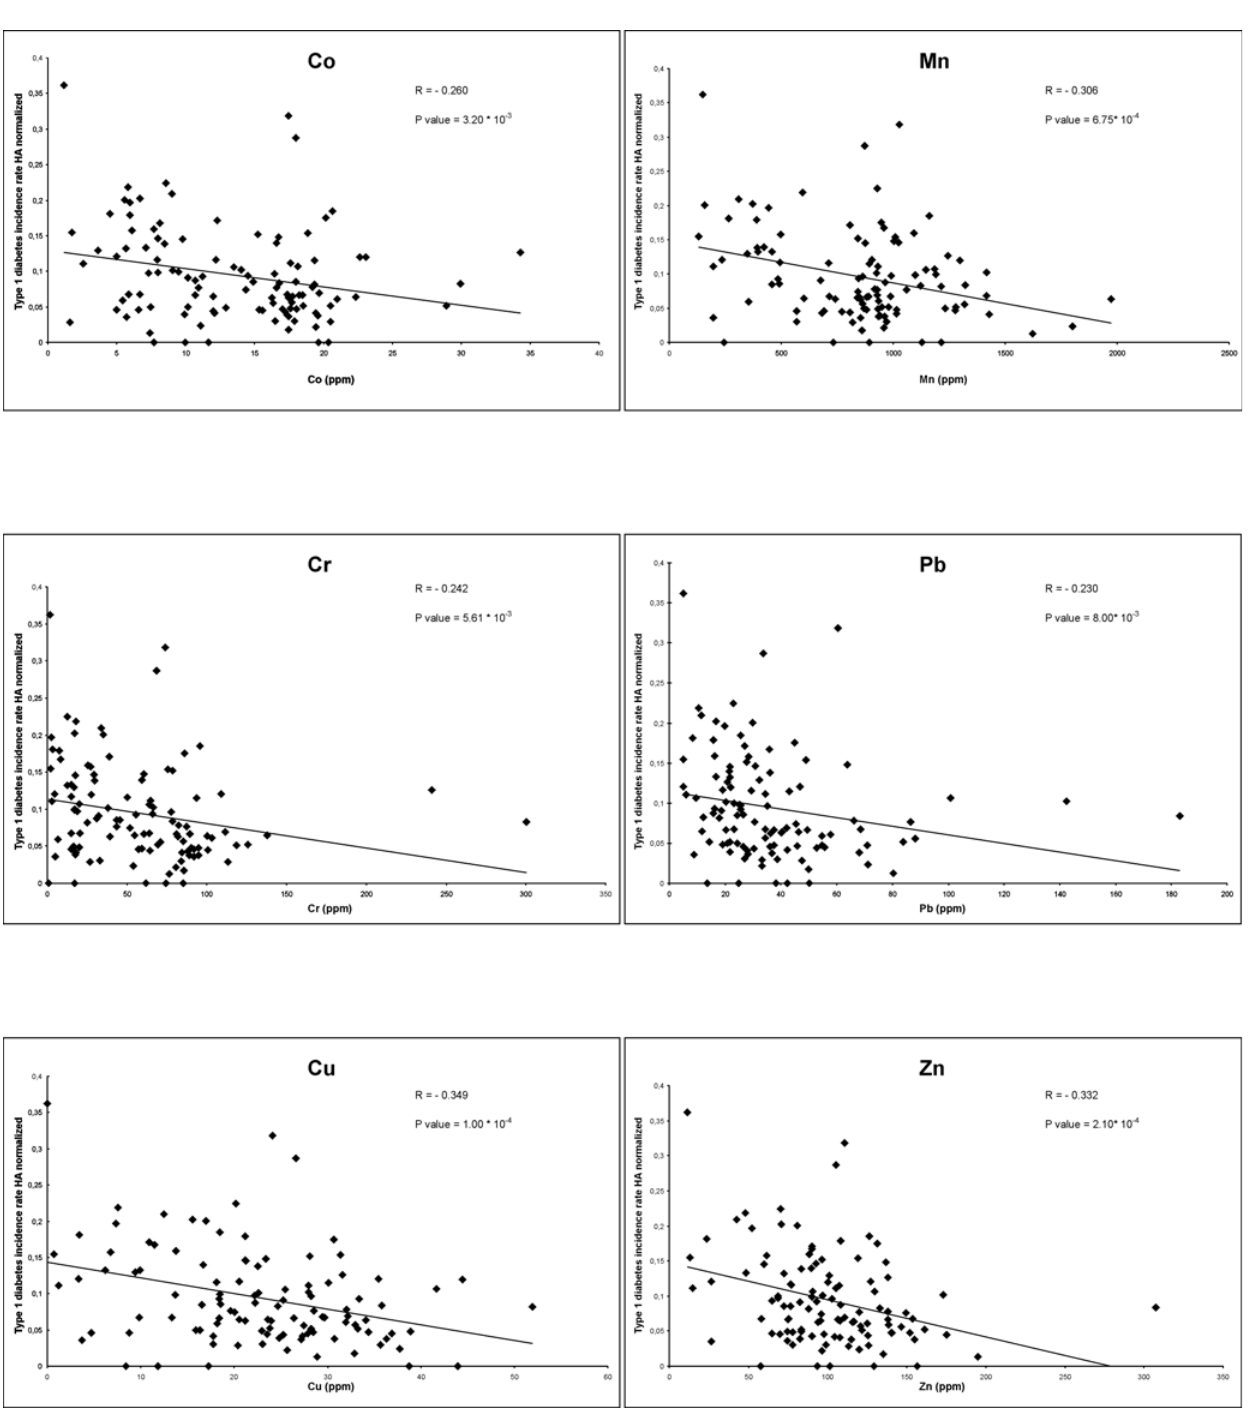
Fig 1. Regression analysis between T1D incidence rate and Co, Cr, Cu, Mn, Pb, Zn. On the X axis the geochemical elements value (ppm) is reported; on the Y axis is reported T1D incidence rate normalized by Homogeneous Areas (HA). For each element the correlation coefficient, R, and the respective P value are